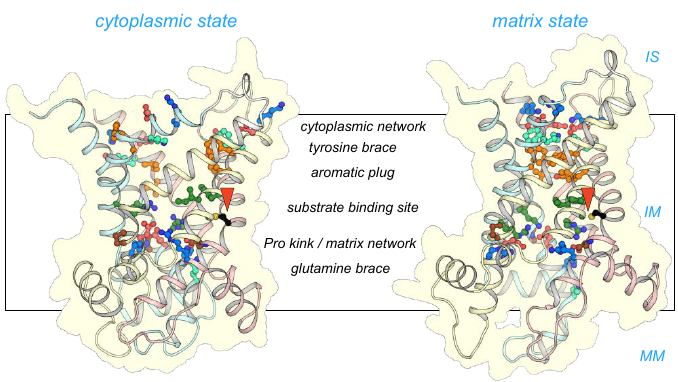
Figure 3. CpAAC has all of the key features of a functional ADP / ATP. Structural models of CpAAC, in the cytoplasmic state ( left ) and matrix state ( right ), based on Protein Data Bank (PDB) entries 4c9g [16] and 6gci [28] respectively, calculated by SWISS-MODEL [38]. Repeats 1, 2, and 3 are colored in pastel blue, yellow, and red, respectively. The residues of the Pro-kink (brown), matrix network (red and blue), glutamine-brace (cyan), substrate binding site (green), aromatic plug (orange), tyrosine-brace (cyan), and cytoplasmic network (red and blue) are indicated. Residue C238 in CpAAC is indicated by a red arrowhead. IS, intermembrane space; IM, mitochondrial inner membrane; MM, mitochondrial